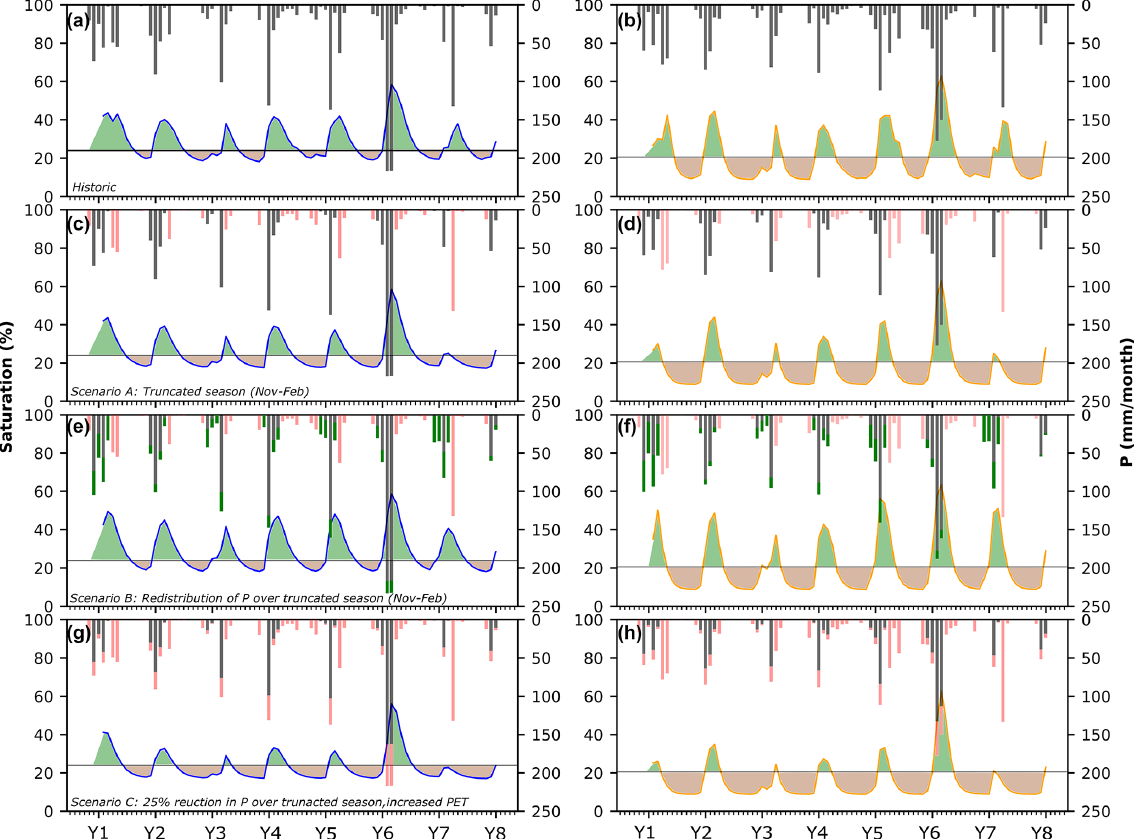
Figure 8. Simulations of soil moisture for the coastal and inland site. Panels (a, b) show historic simulations. (c, d) Scenario A showing a truncated rainy season. Red bars indicate precipitation loss. (e, f) Scenario B showing a redistribution of annual P over the truncated season. Green bars indicate additional P , and red bars indicate P loss. (g, h) Scenario C showing a truncated season with additional 25% loss of P and an increased evaporative demand equal to a + 4 ◦ C increase in mean annual temperature. The horizontal line indicates a vegetation stress threshold below which water becomes limiting for plants. Green shading indicates periods of greenness, while brown shading highlights periods of